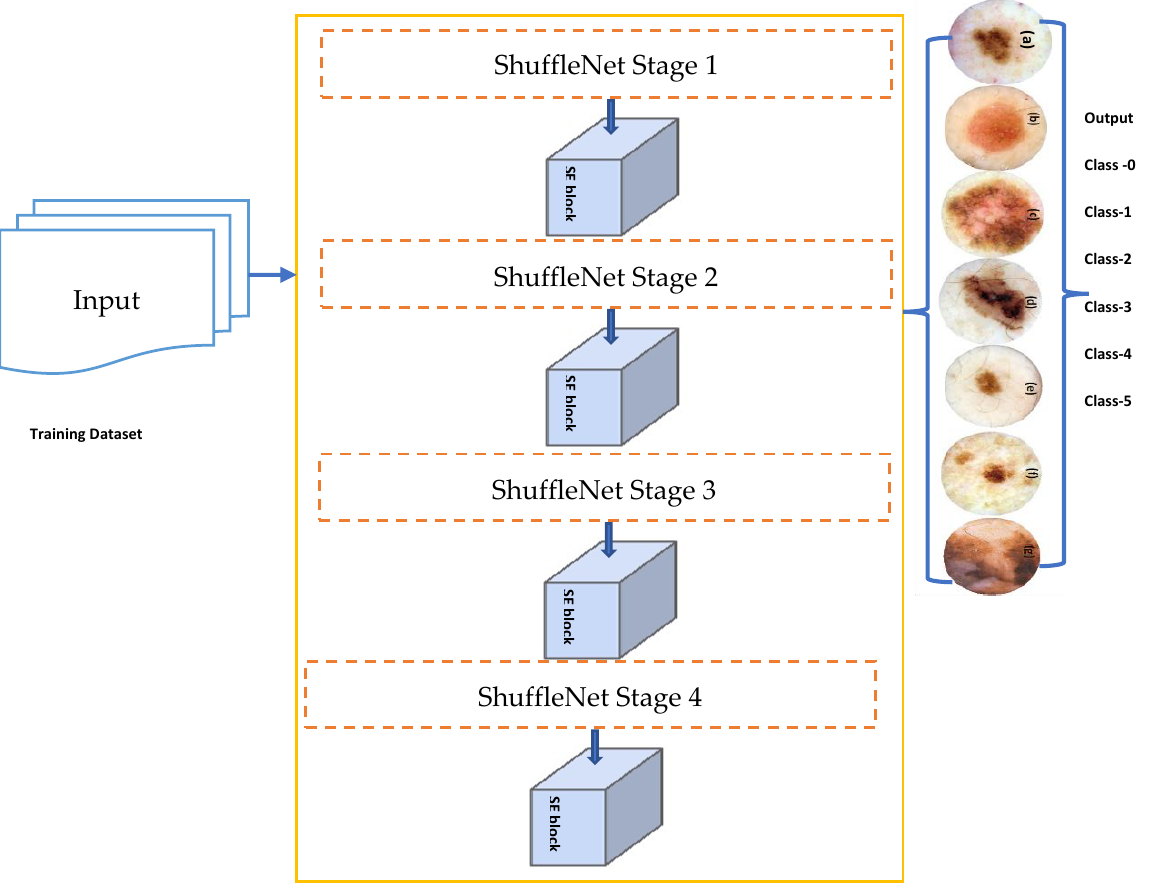
Figure 4. A systematic flow diagram of the improved ShuffleNet architecture.